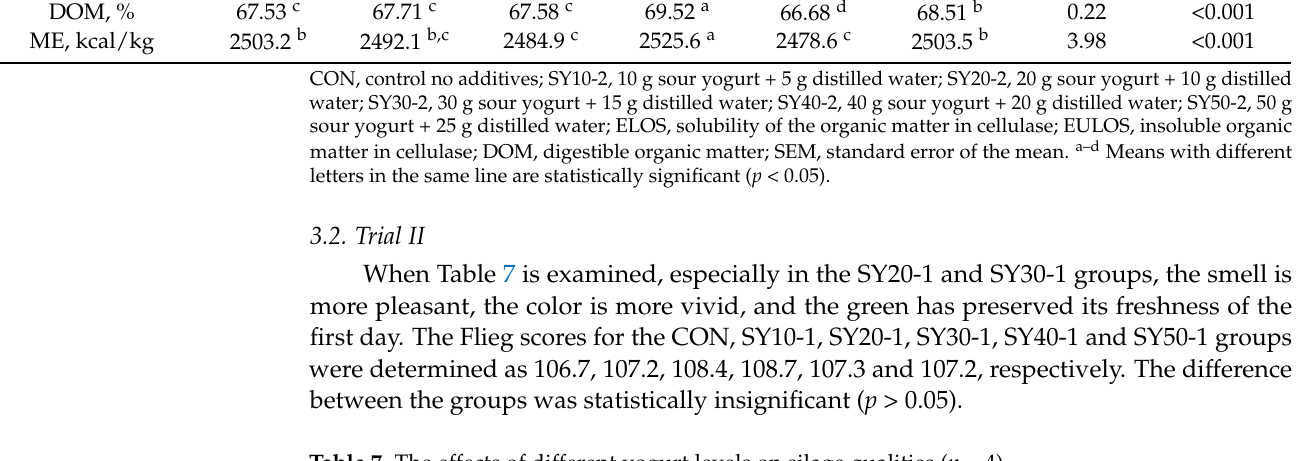
Table 7. The effects of different yogurt levels on silage qualities ( n =